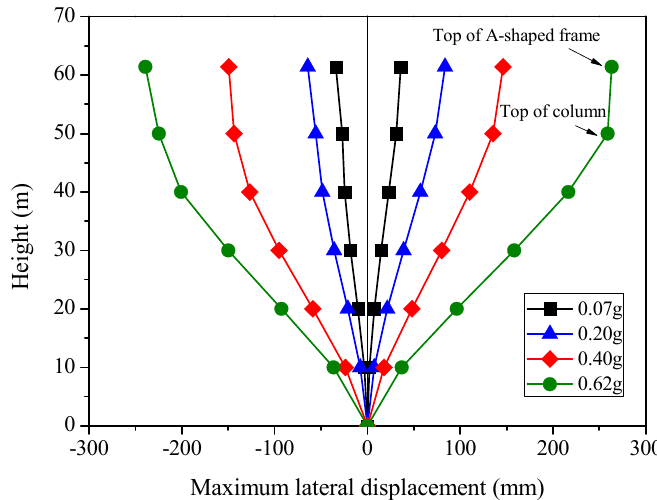
Figure 9. Maximum lateral displacement versus height curves under different hazard levels.